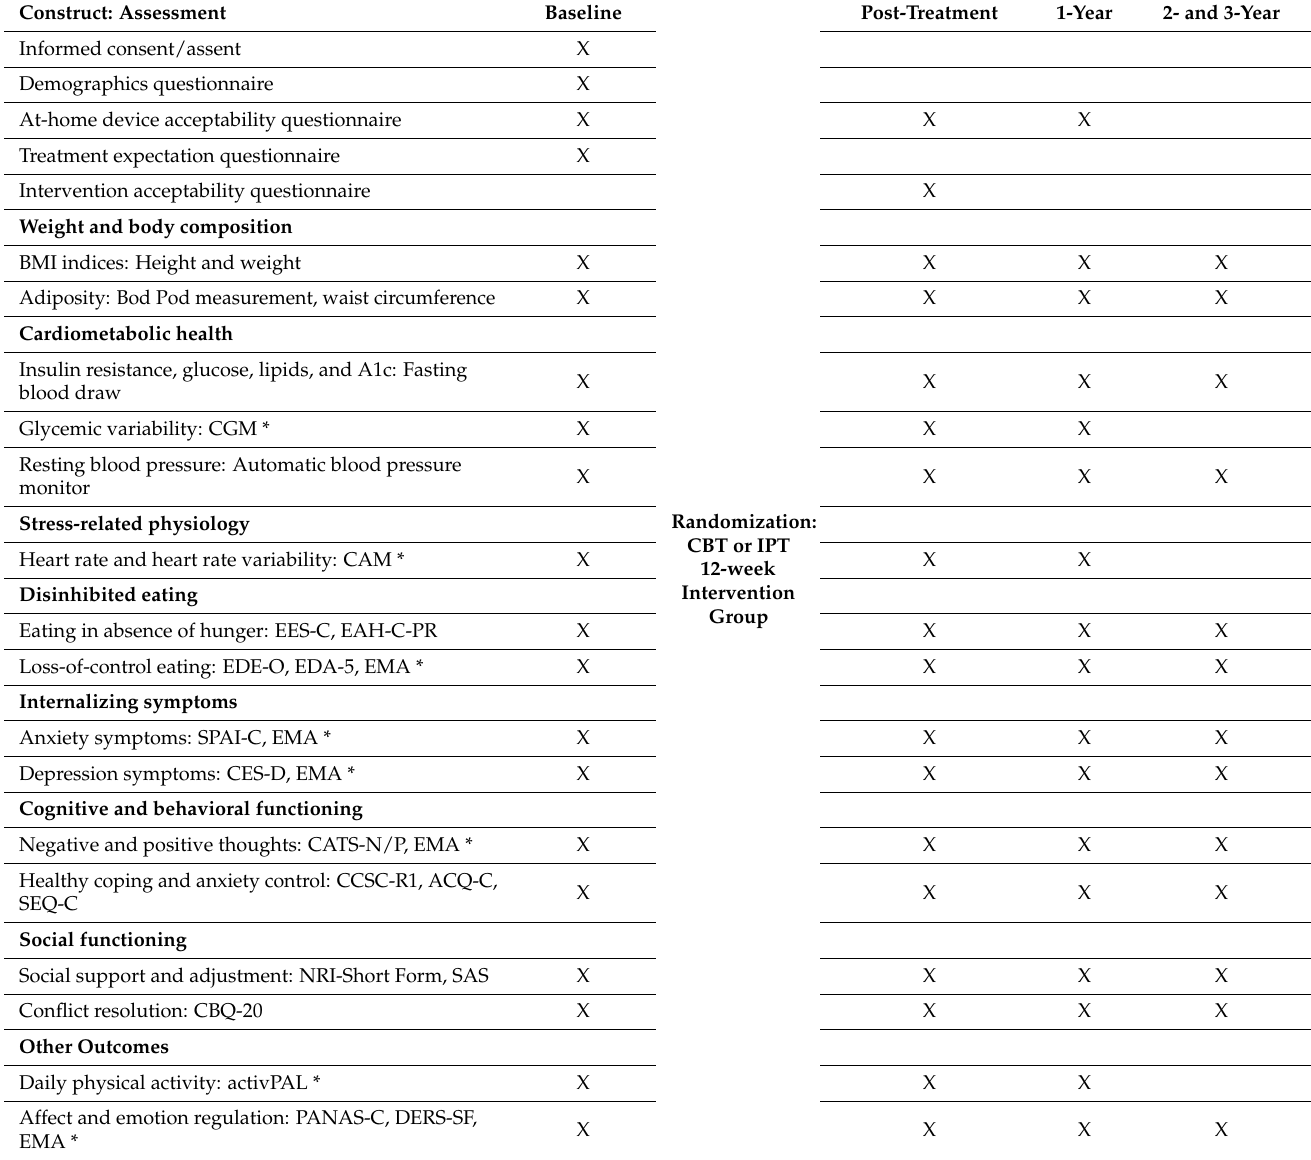
Table 1. Overview of a participant timeline, assessment intervals, and core